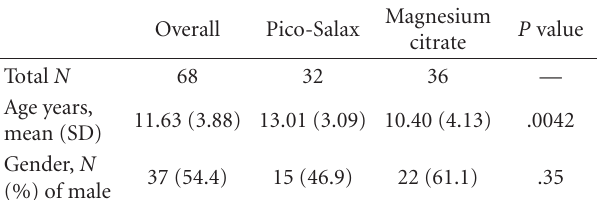
Table 1: Patient